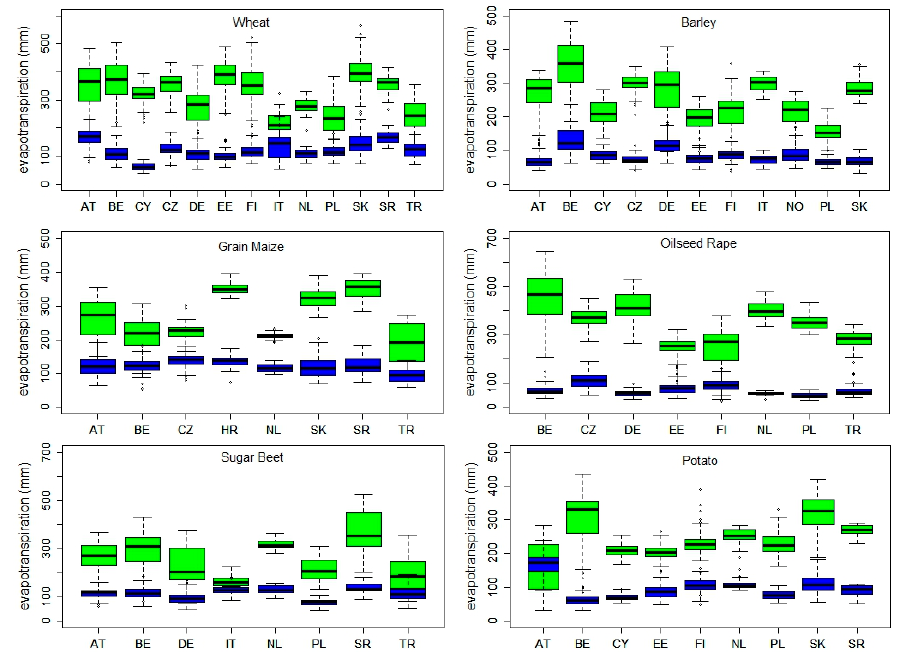
Figure 6. Transpiration ( T in mm, green) and evaporation ( E in mm, blue) for major arable crops across the European regions for the period 1992–2012. A two letter code refers to the country that the region belongs to.